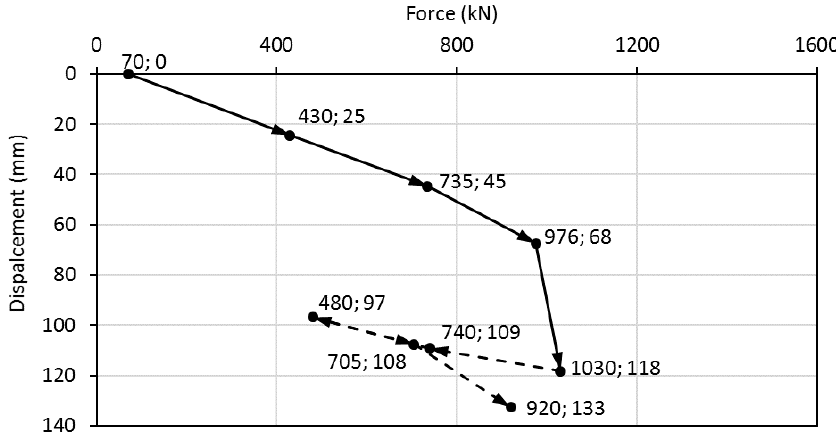
Figure 4. Displacement of anchor head as function of axial force during load test.